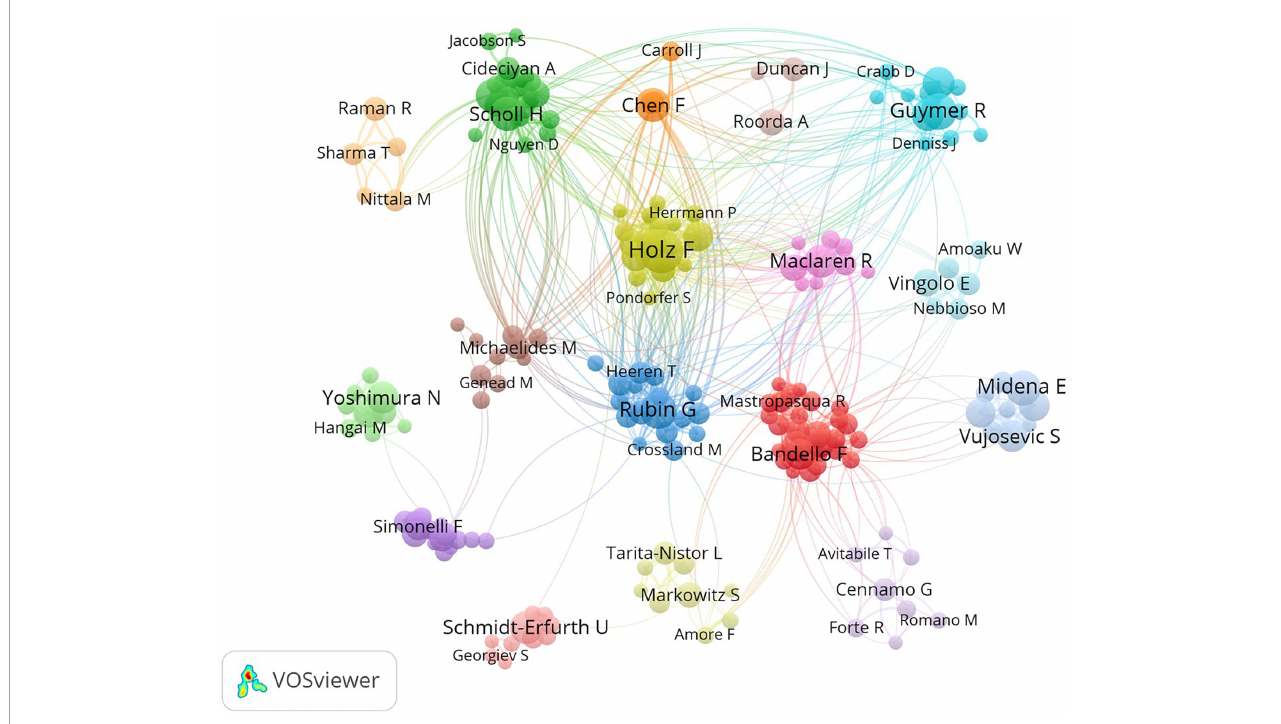
FIGURE4 Co-authorship map of authors. The size of nodes demonstrated the frequency of authorship. The curves between the nodes illustrated their co-authorship in the same publication. The shorter distance between the two nodes showed the closeness of the co-authorship of the two authors.